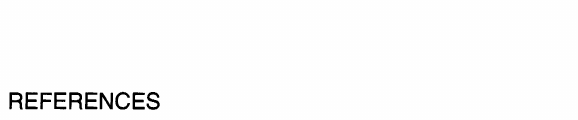
tation" (F = 4.683; p = 0.0093). The interaction "con dition X order of presentation" was also significant (F = 5.864; p = 0.0032). The variable "session" was not